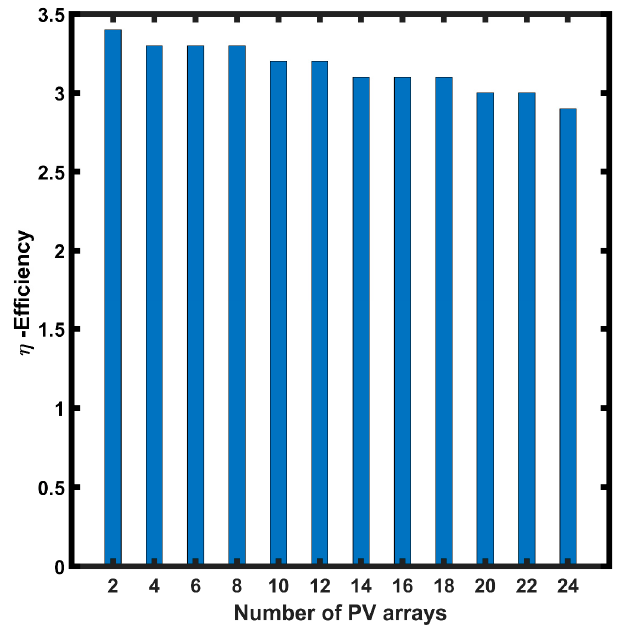
Figure 7. Annual efficiency improvements of the PV vs. the number of PV panel Figure 7. Annual e fficiency improvements of the PV vs. the number of PV panel arrays.